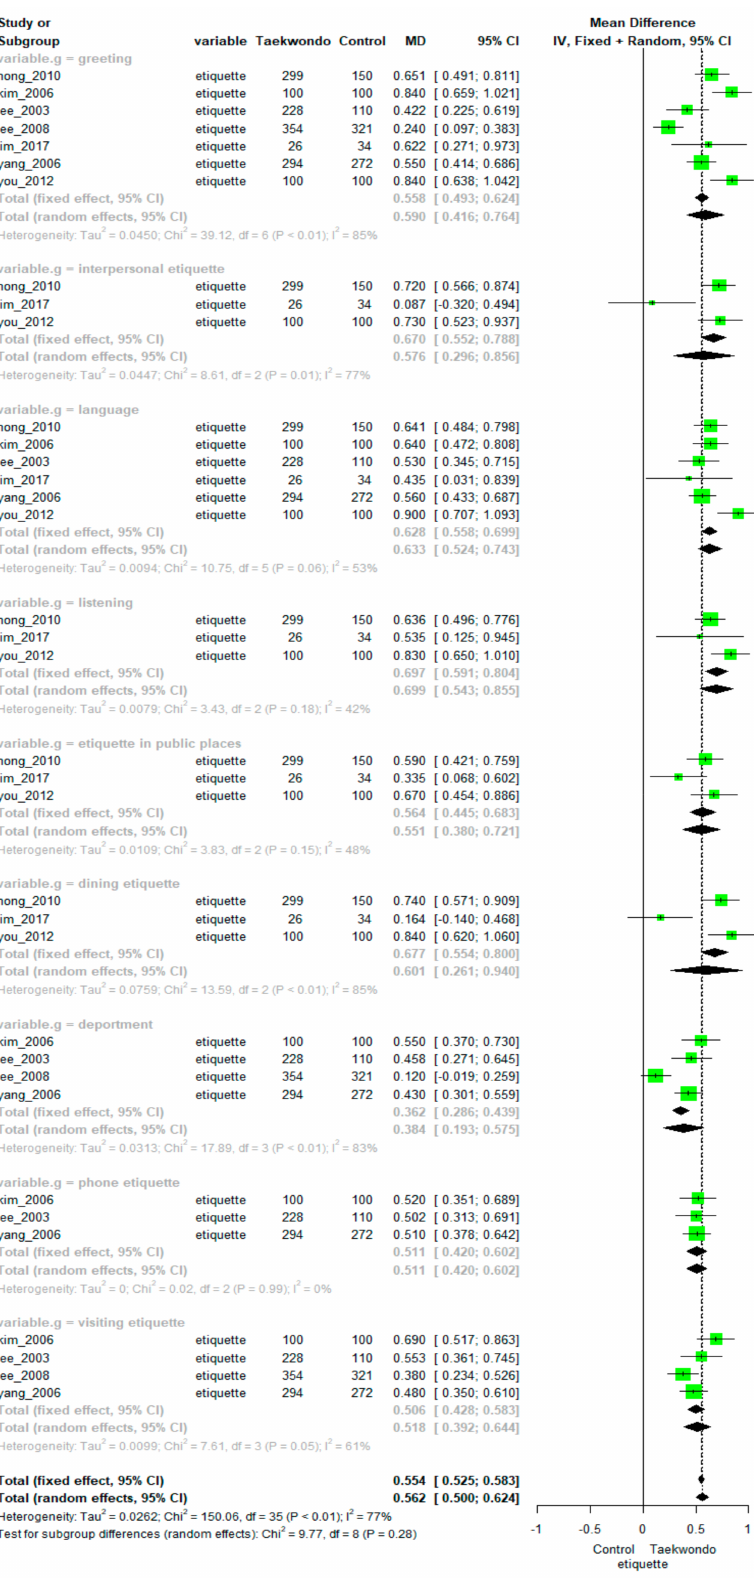
Figure 4. Forest plot of Taekwondo’s effects on